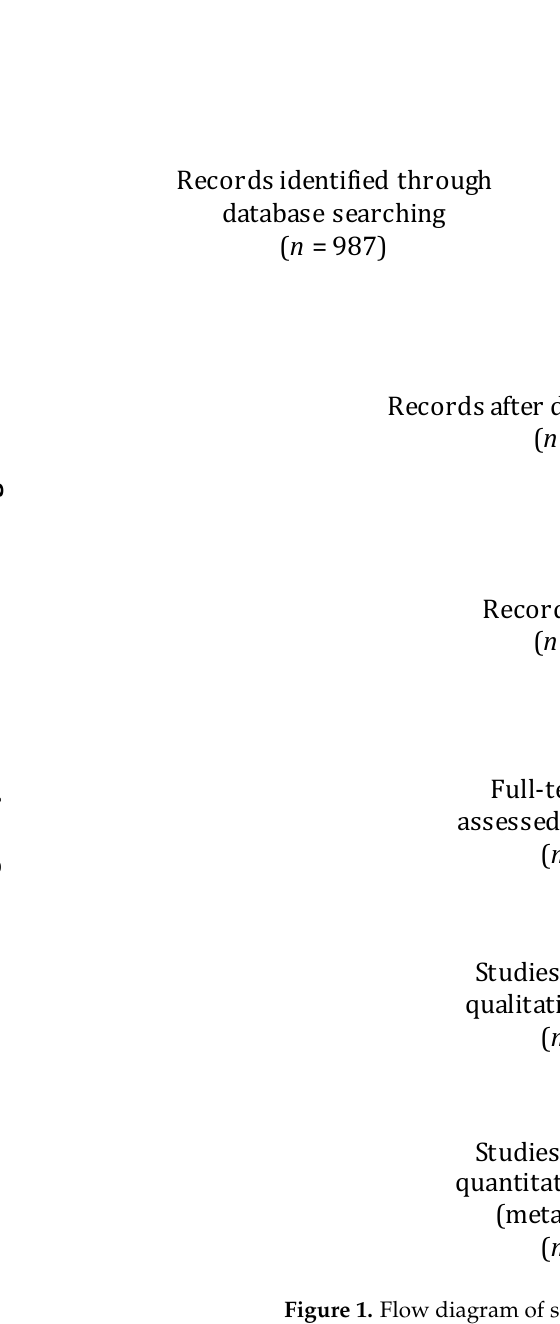
Figure 1. Flow diagram of study selection process.